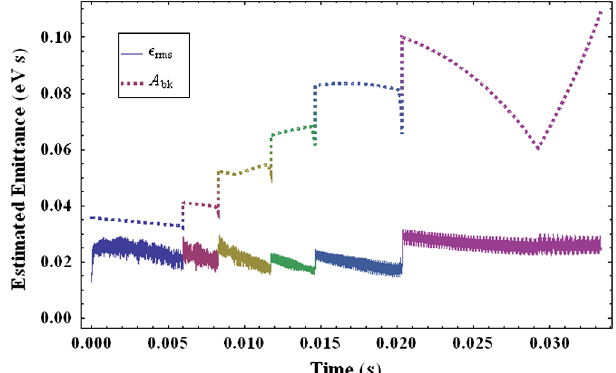
FIG. 6. Rootmeansquarebunchemittance, ϵ A , are shown for a simulated ramp with carbon ions and a fixed bk voltage profile. The emittance spikes correspond to the harmonic transitions inducing a quick change in synchronous phase.